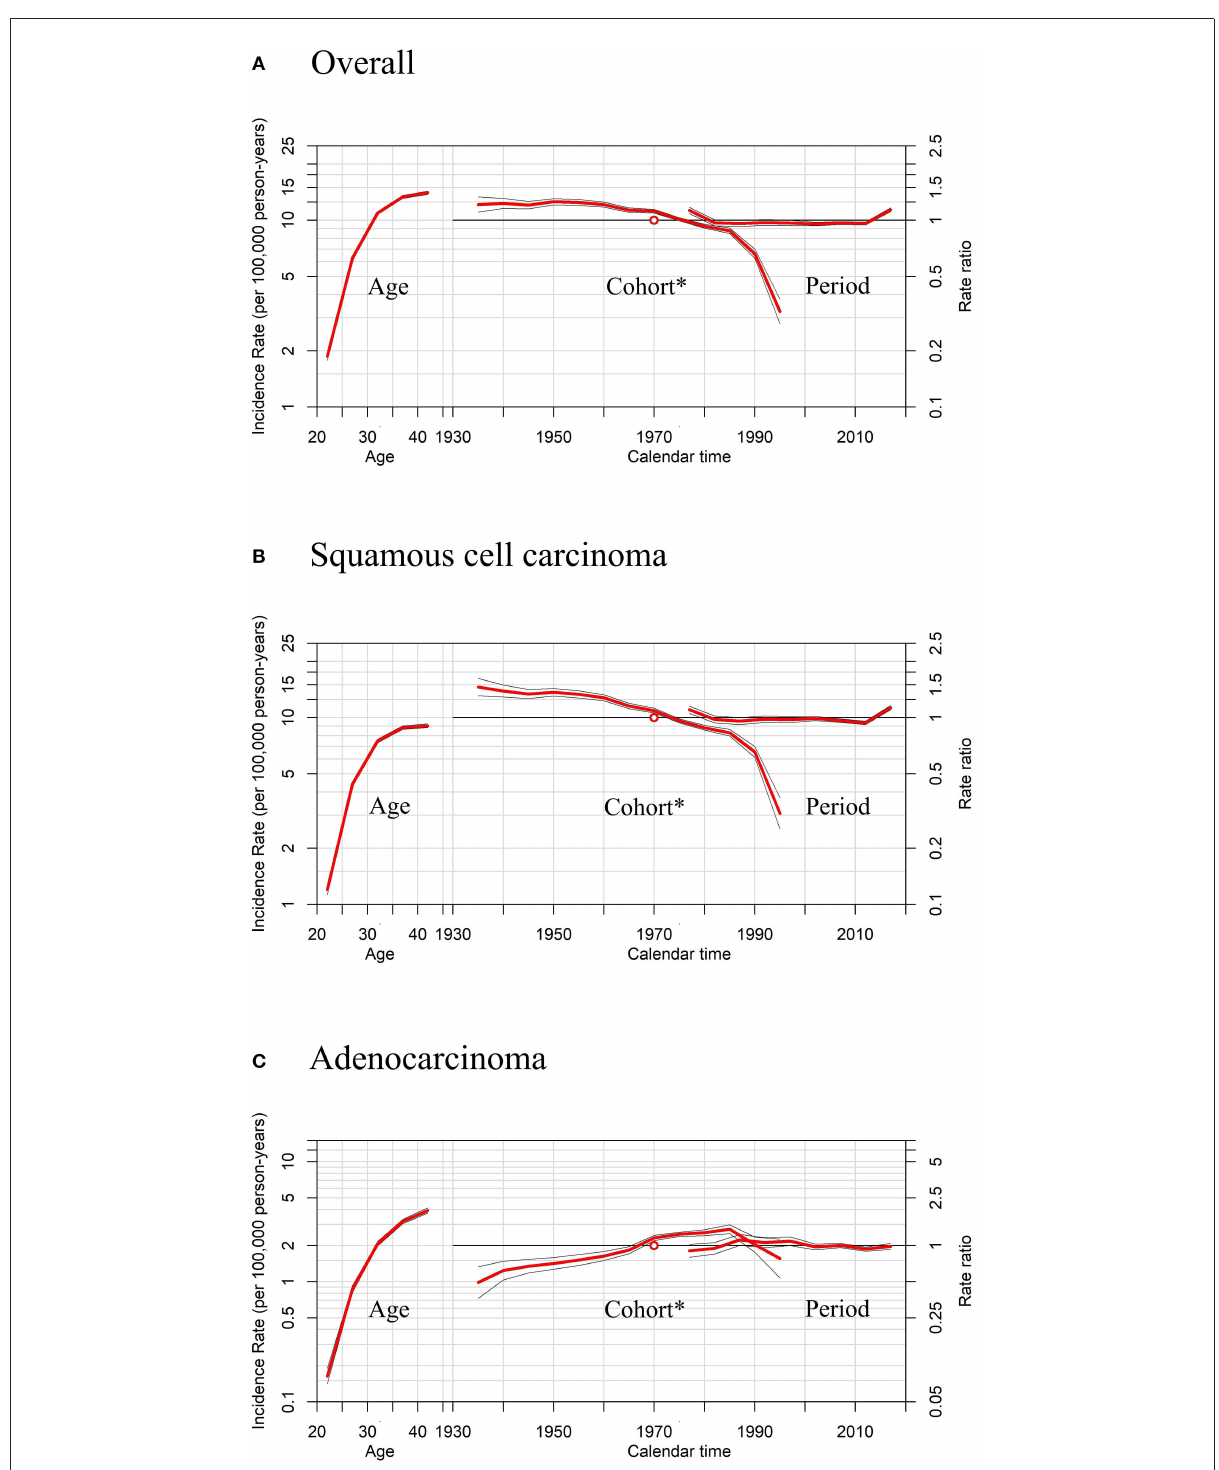
FIGURE6 Age, period, and cohort* effects in cervical cancer incidence rates among females aged 20 to 44 years by histology, United States. (A) Effects of all histopathologic subtypes combined. (B) Effects of squamous cell carcinoma (SCC). (C) Effects of adenocarcinoma (AC). * Each plot’s horizontal axis is divided into two parts: age, ranging from 20–44 years (left), and calendar time, ranging from 1935–2020 (right). Each plot contains two vertical axes: cervical cancer incidence per 100,000 person-years (left) and rate ratios (right), and three sets of curves: age effects, with corresponding 95% confidence intervals (left); cohort effects, with corresponding 95% confidence intervals (middle); and period effects, with corresponding 95% confidence intervals (right). In cohort effects, the slope of the period was constrained to be 0 to analyze the cohort effect, and the empty red circle represents the reference cohort of 1970 (median date of birth among cervical cancer